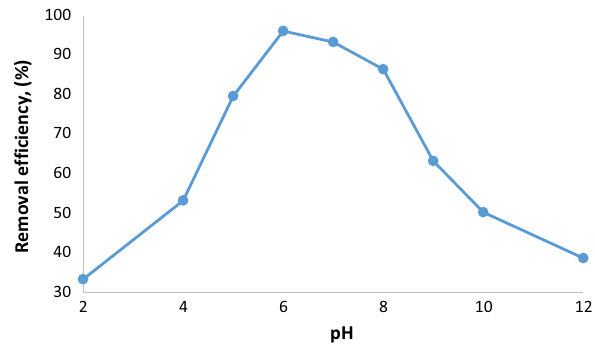
Fig. 6 Effect of adsorbent dosage on the removal percentage